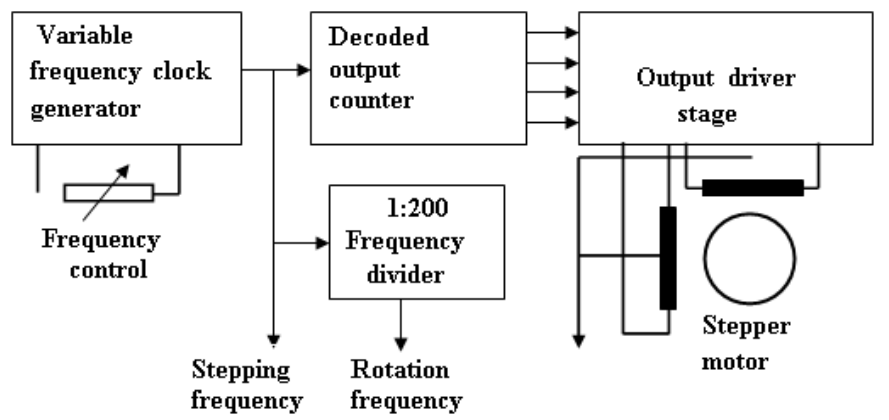
Figure 9. The block diagram of electronic driving circuits.